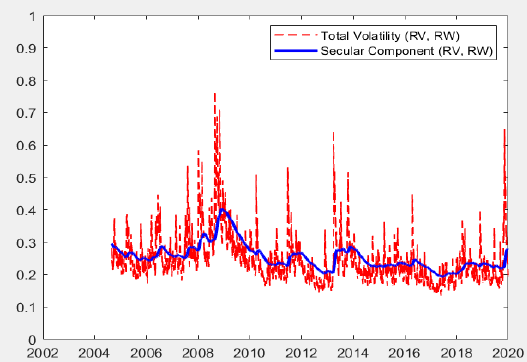
Figure 1. Total Variance and Long-Run Component with RV.